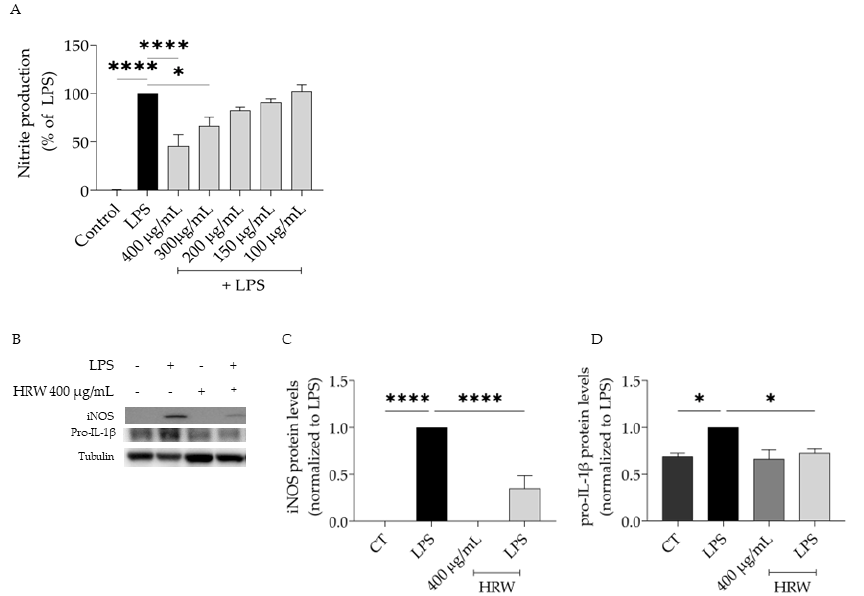
Figure 5. Anti-inflammatory potential of T. capitata hydrodistillation residual water (HRW). Effect of the HRW on nitrite production ( A ) and protein levels of iNOS ( B , C ) and pro-IL-1 β ( B , D ) in lipopolysaccharide (LPS)-stimulated macrophages. * p < 0.05. Furthermore, **** p < 0.0001 when compared to control (CT) or LPS after one-way ANOVA followed by Dunnett’s multiple comparison